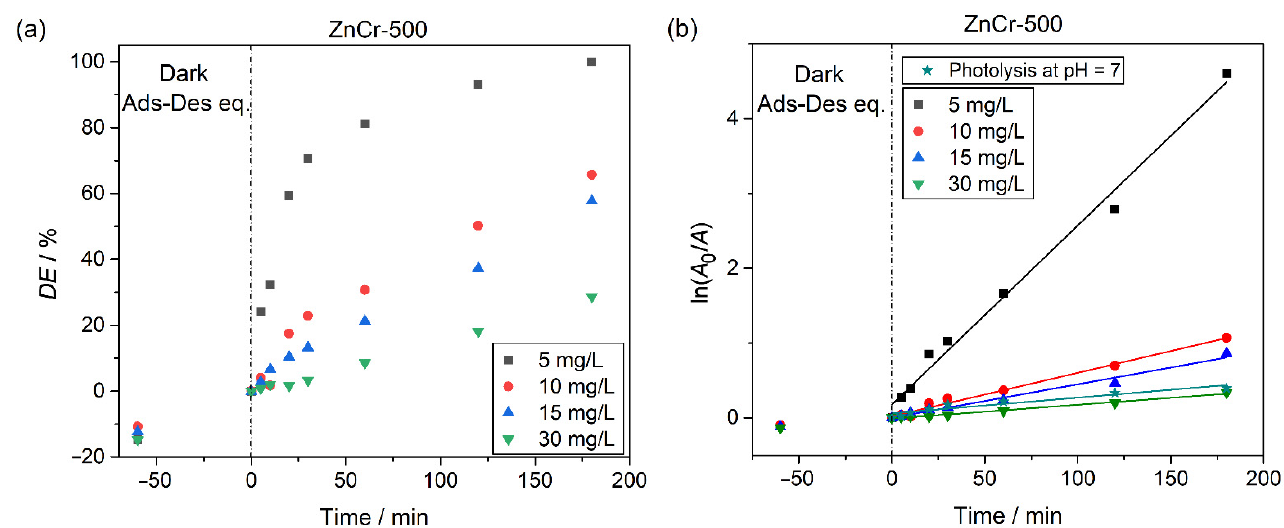
Figure 11. Analysis of the effect of the initial CV dye concentration in the photocatalytic degradation using ZnCr-500 as photocatalyst (50 mg), at pH = 7. ( a ) Plot of the degradation percentage vs. time, and ( b ) kinetics plot for obtaining the rate degradation constant. Table 2. Rate degradation constant for the tests using different CV dye concentration.